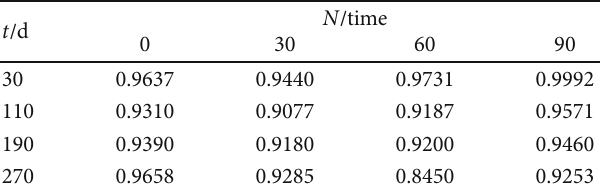
Table 3: Values of the parameter A and corrosion time.